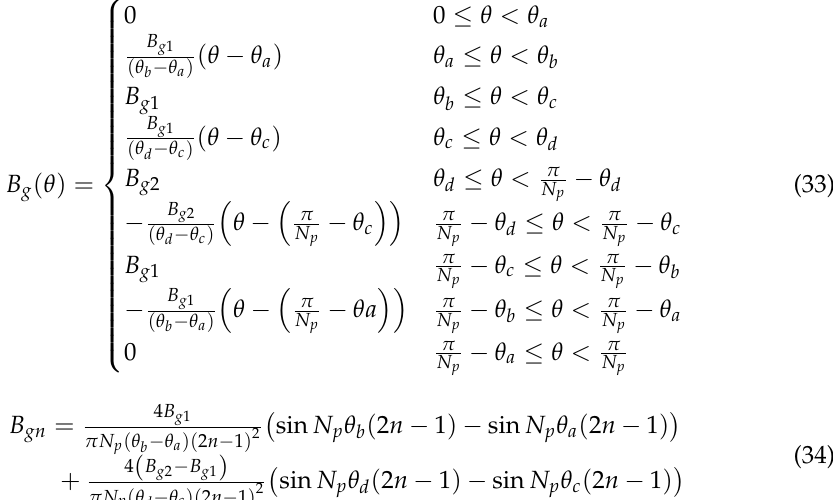
Figure 13. Comparison of flux density distribution of the air gap with bar-type and V-type rotors with slots: ( a ) HMEC, ( b ) FEM. Figure 14. Comparison of cogging torque with bar-type and V-type rotors with slots: ( a ) HMEC, ( b )